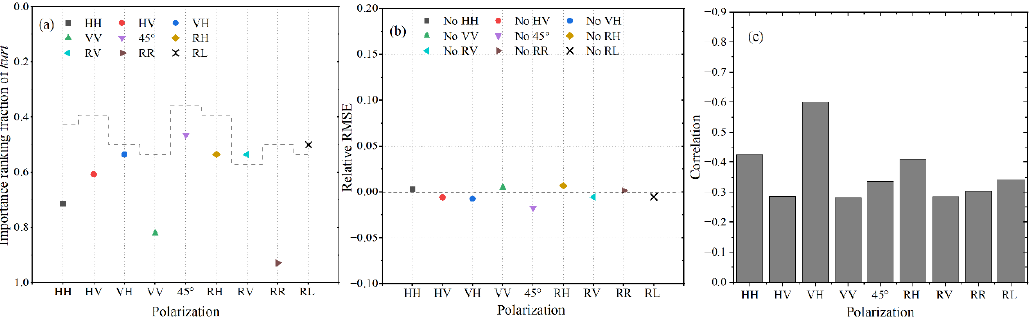
Figure 16. The importance of skew to SWH retrieval from single-polarization models. ( a ) The importance ranking of skew provided by XGBoost models normalized to 0–1. The dotted line represents the optimal feature sets under different polarizations. ( b ) The effect of removing skew on the SWH estimation from different polarized models. Different markers in various colors represent skew of different polarizations. ( c ) The correlation between skew and ERA5 SWH under different polarizations.